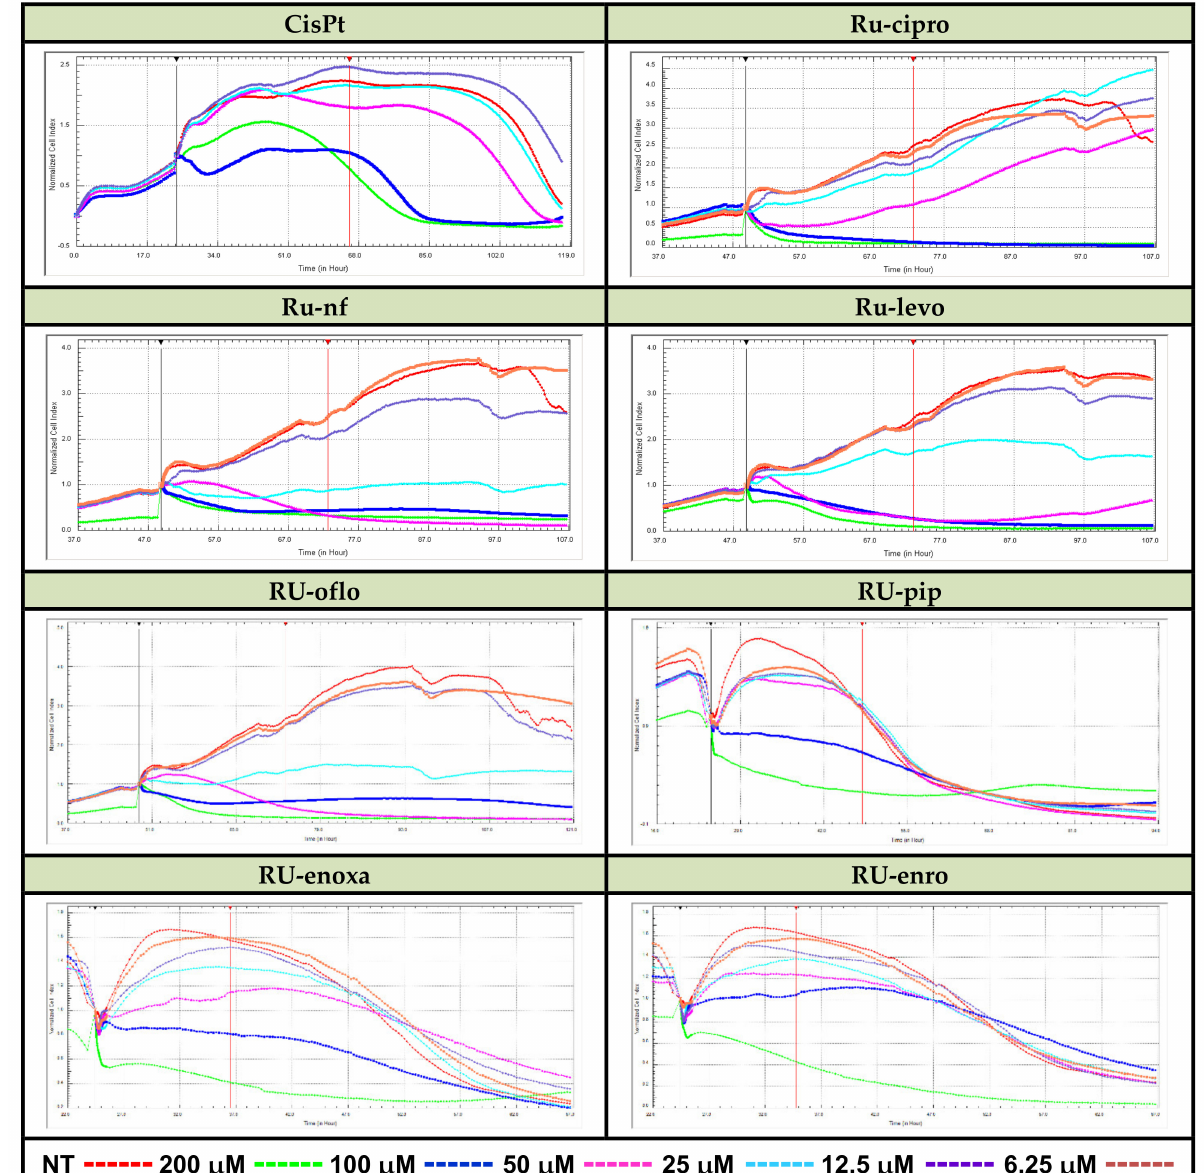
Figure 2. Real-time cell analysis of cytotoxic effects of Ru(III) complexes vs. CisPt. LoVo human colon cancer cells were treated with the reported drug concentrations in 16-well E-plates. Monitoring of Ru(III) complexes-mediated cytolysis was performed by measuring the cell index for several days using the xCELLigence DP-System and compared to CisPt-induced inhibition of proliferation vs. cell